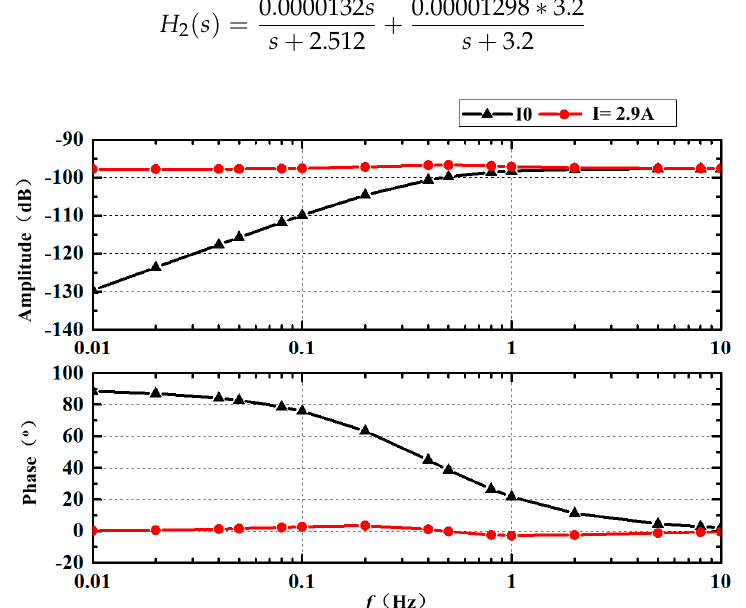
Figure 12. Frequency response simulation results of C-MHD ARS.